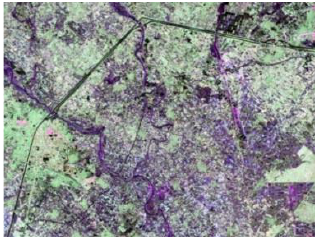
image shown in figure 7.